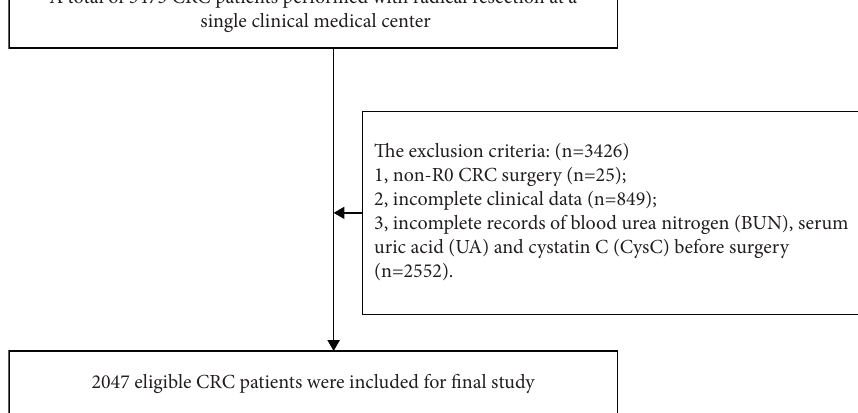
Figure 1: Flowchart for patient